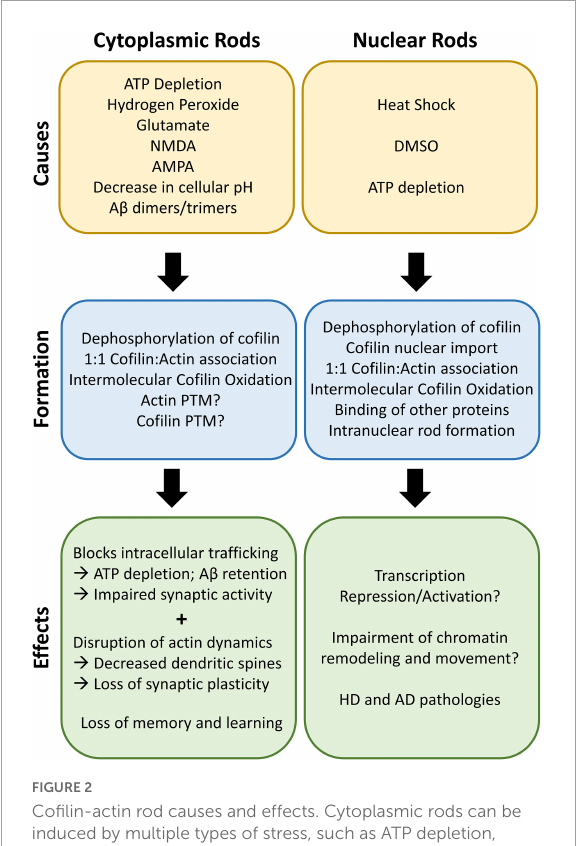
FIGURE2 Cofilin-actin rod causes and effects. Cytoplasmic rods can be induced by multiple types of stress, such as ATP depletion, oxidative stress, and a decrease in cellular pH. Dephosphorylation of cofilin and association with actin in a 1:1 ratio leads to rod formation in the presence of oxidative stress. Post-translational modifications (PTM) of actin and cofilin may also be an emerging area for rod regulation. The rods block critical intracellular trafficking of organelles such as mitochondria and results in ATP depletion and impaired synaptic activity. The disruption of actin dynamics due to sequestered cofilin decreases dendritic spines and loss of synaptic plasticity, leading to loss of memory and cognitive ability over time. Interestingly, nuclear rods are similarly formed in the nucleus after nuclear translocation due to heat shock, DMSO, or ATP depletion. Other actin-binding proteins (ABPs), including the Huntingtin mutant, associate with the nuclear rods and form persistent rods that can affect transcription and chromatin remodeling. Both cytoplasmic and nuclear rods can lead to AD, HD, and PD